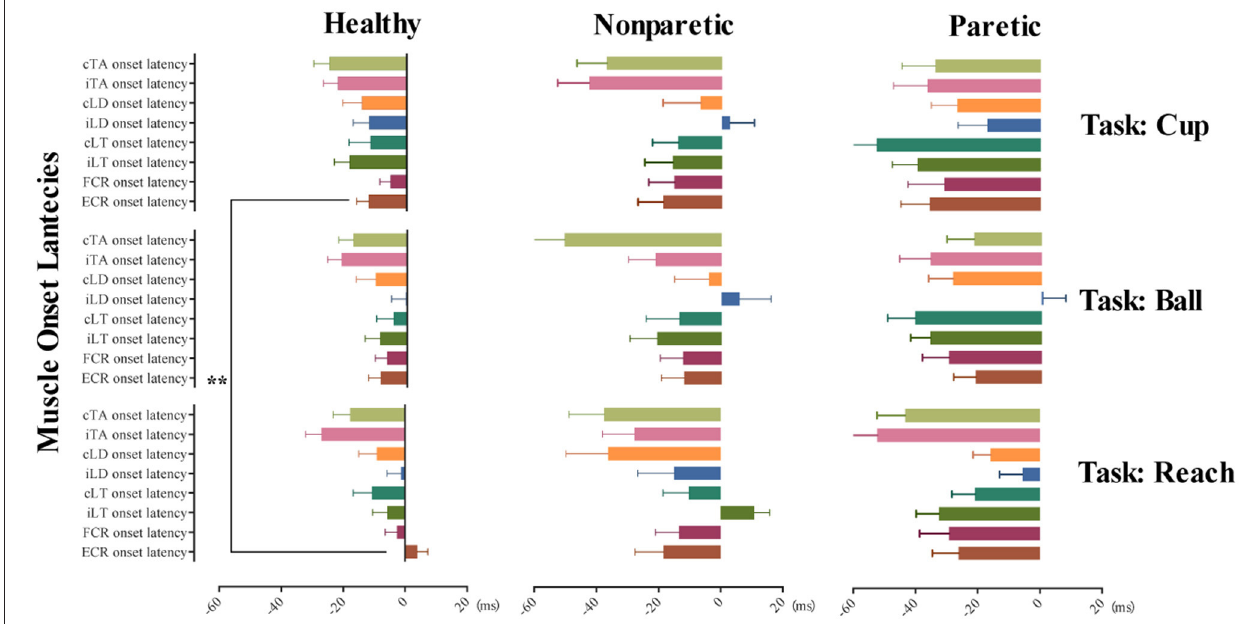
FIGURE 2 | Tunes of AMA onset in the three move tasks of the healthy, non-paretic, and paretic side. This illustrates the tunes of AMA onset in task reach, grasp a ball, and grasp a cup with different move sides, including healthy subjects, non-paretic side, and paretic side of stroke subjects, respectively. Horizontally arranged from left to right are the mean with SEM of AMA onset latency in healthy, non-paretic, and paretic sides; vertically arranged from top to bottom are the different AMA onset latency (mean with SEM) in tasks cup, ball, and reach. ** p- value < 0.01.